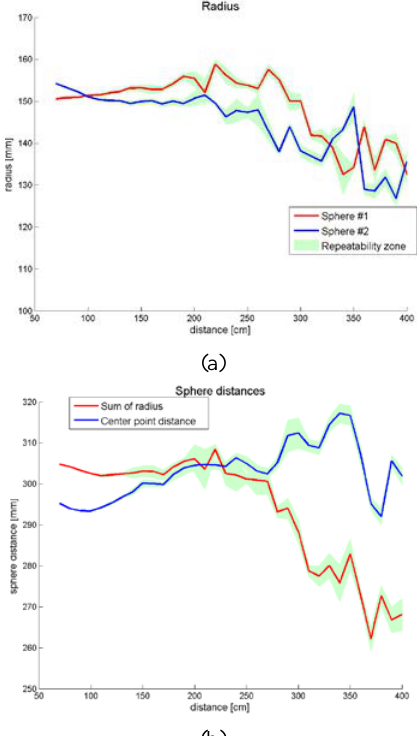
Figure 9. Radius of fitted spheres (a), and sum of radiuses and center point distances